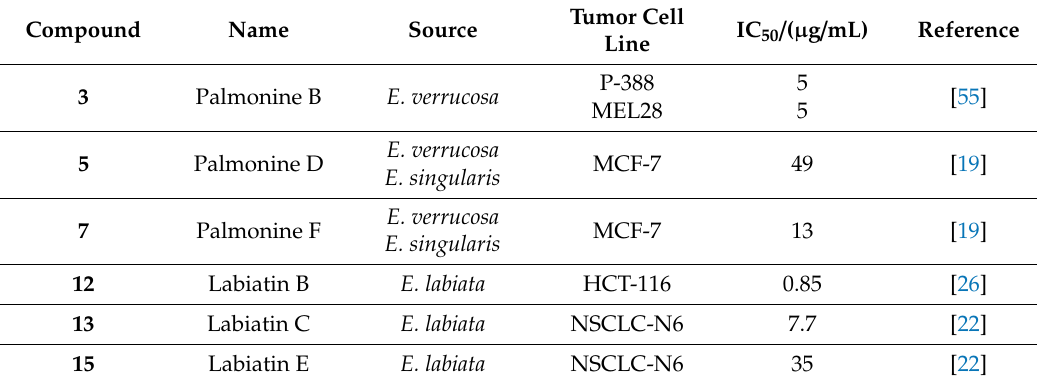
Table 1. The most promising diterpenoids with remarkable cytotoxic activity isolated and studied from corals of the genus Eunicella